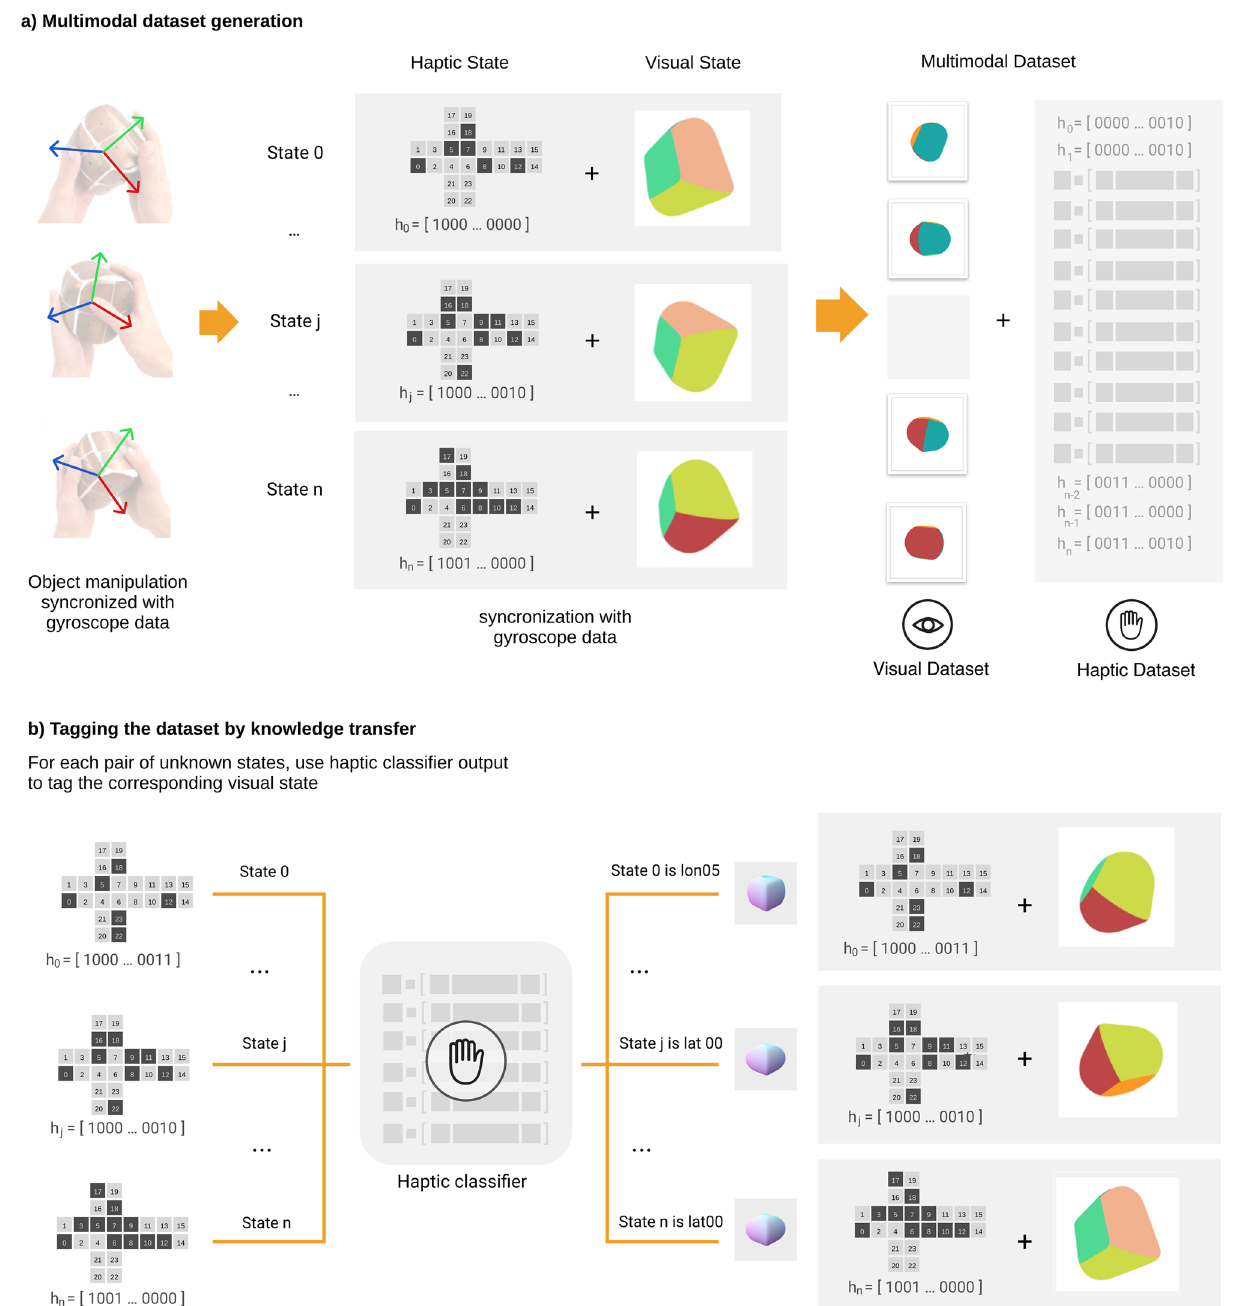
Figure 3. Multimodal dataset generation through knowledge transfer. ( a ) Using the gyroscope, we can obtain the orientation of the object associated to each haptic state. From this information, we can draw (through 3D renders) a visual state of the object and associate it with its corresponding haptic state. From this, given any haptic dataset we can generate its corresponding visual dataset. With this method a new multi-modal dataset is created as a result of the combination of haptic and visual datasets. ( b ) Given that no manual annotation process has been carried out in the creation of the previous multi-modal dataset, the visual mode is not labelled. Here, we propose to tag the visual dataset from the results of the haptic object recognition system. This transfer of information generates a link between the two modes, visual and